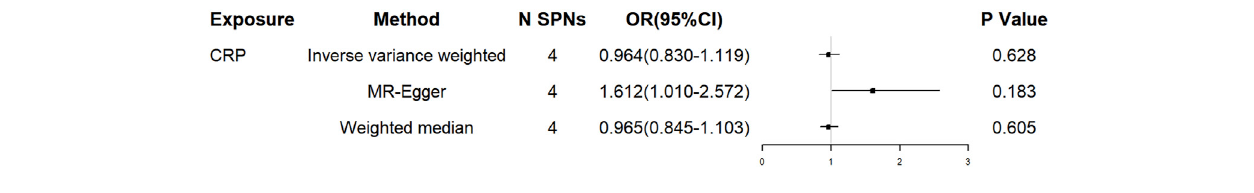
FIGURE 3 | The effect of overall conservative CRP genetic variants on ALS. OR, odds ratio; CI, con fi dence interval.